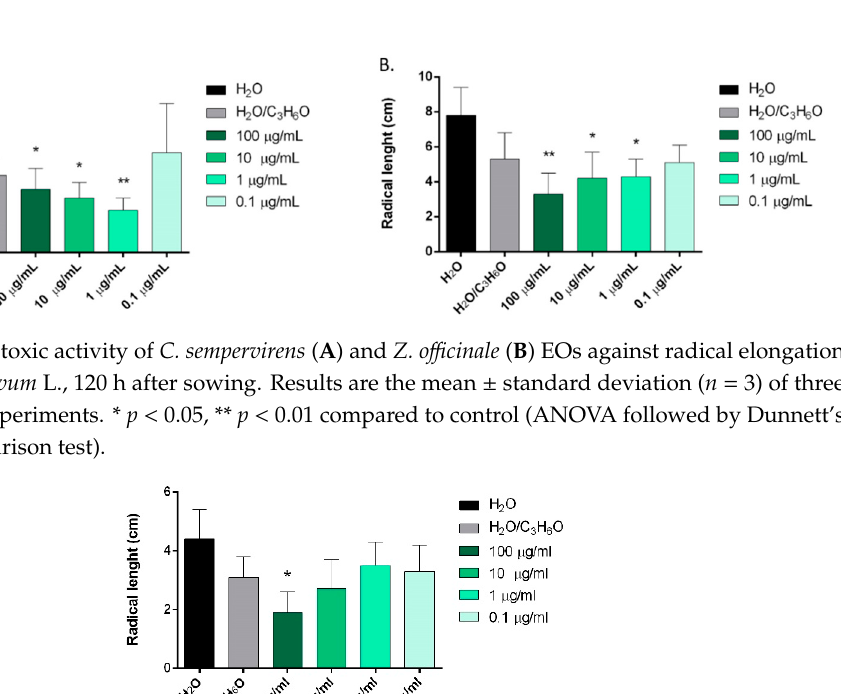
Figure 4. Phytotoxic activity of Z. officinale EO against radical elongation of Lolium multiflorum Lam.,120 h after sowing. Results are the mean ± standard deviation ( n = 3) of three independent experiments. * p < 0.05, compared to control (ANOVA followed by Dunnett’s multiple comparison test).